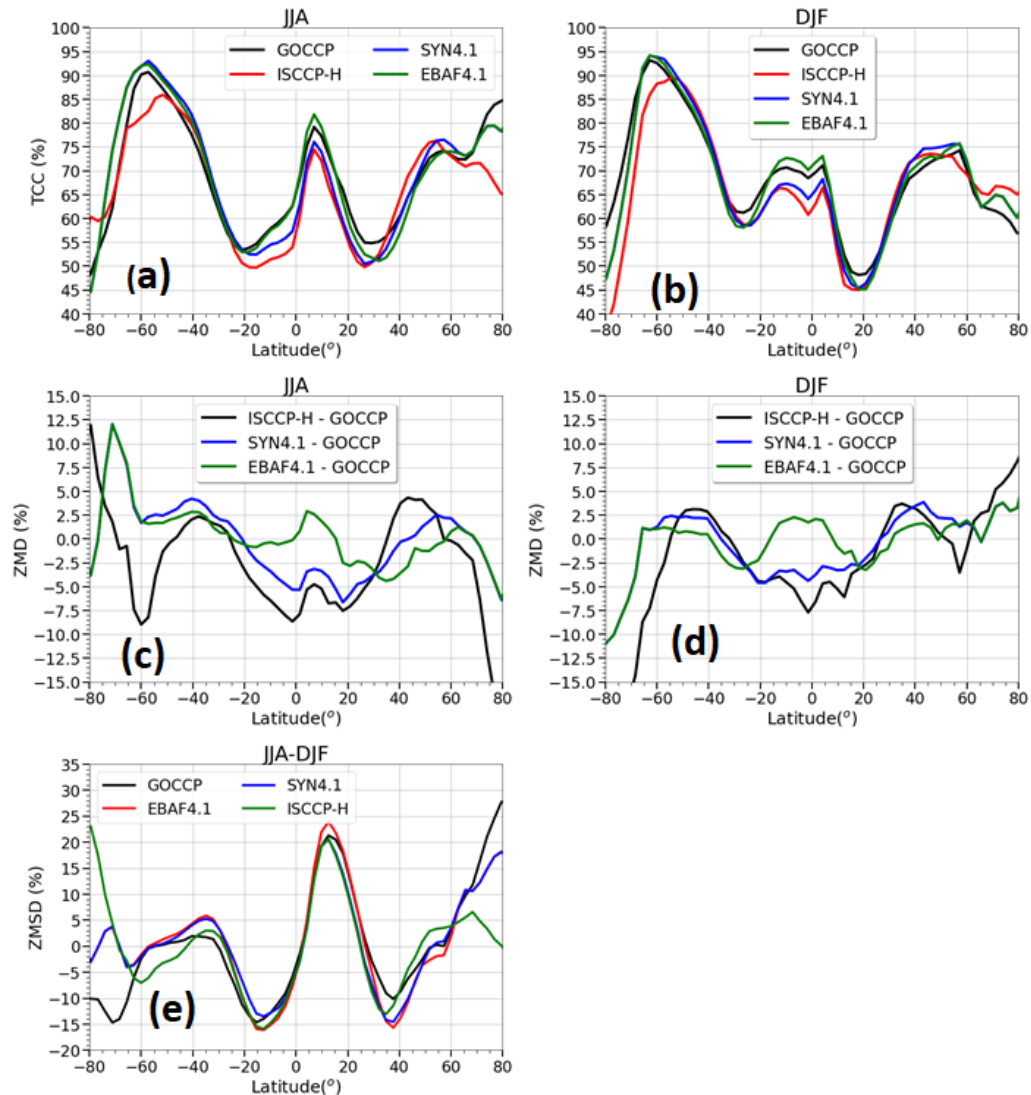
Figure 8. Zonally and seasonally averaged TCC for summer (JJA) ( a ) and winter (DJF) ( b ), zonal mean difference (ZMD) between active and passive sensors for JJA ( c ) and for DJF ( d ), and zonal mean seasonal difference (ZMSD) (JJA-DJF) ( e ).